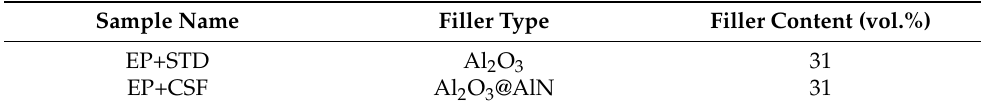
Table 3. Details and definition of the investigated filled epoxy composites.